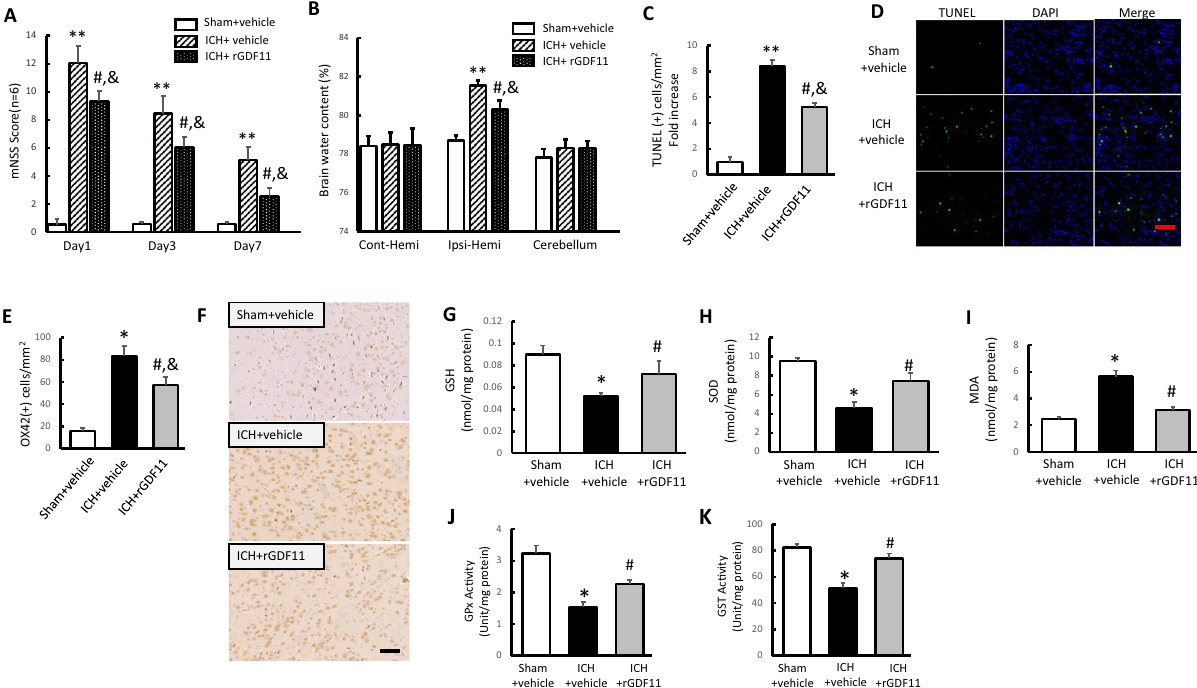
Figure 1. GDF 11 attenuated ICH secondary injuries in elderly rats. ( A ) Modified neurological severity scores (mNSS) of different groups on day 1, 3, and 7 post-ICH. ( B ) Brain water content of contralateral hemisphere, ipsilateral hemisphere and cerebellum on day 3 post-ICH expressed as percentage of the wet weight. ( C , D ) The peri-hematomal TUNEL-positive cells on day 3 post-ICH, presenting as fold increases ( C ) and TUNEL/DAPI-fluorescence staining (scale bar 200 μm) ( D ). ( E , F ) OX-42 (+) cells counting ( E ) and OX-42 immunohistochemical staining (scale bar 50 μm) on day 3 post-ICH ( F ). ( G – I ) ICH-induced oxidative stress indicators shown as GSH ( G ), SOD ( H ) and MDA ( I ) on day 3 after ICH surgery. ( J , K ) GPx activity and GST activity in the indicated groups on day 3 after ICH surgery. Values shown as mean ± SD. *p < 0.05 and **p < 0.01 versus sham + vehicle group; # p < 0.05 versus ICH + vehicle group and & p < 0.05 versus sham + vehicle group. n = 6–8 animals per group. TUNEL terminal deoxynucleotidyl transferase dUTP nick end-labelling, DAPI 40,6-diamidino-2-phenylindole, GSH glutathione, SOD superoxide dismutase, MDA